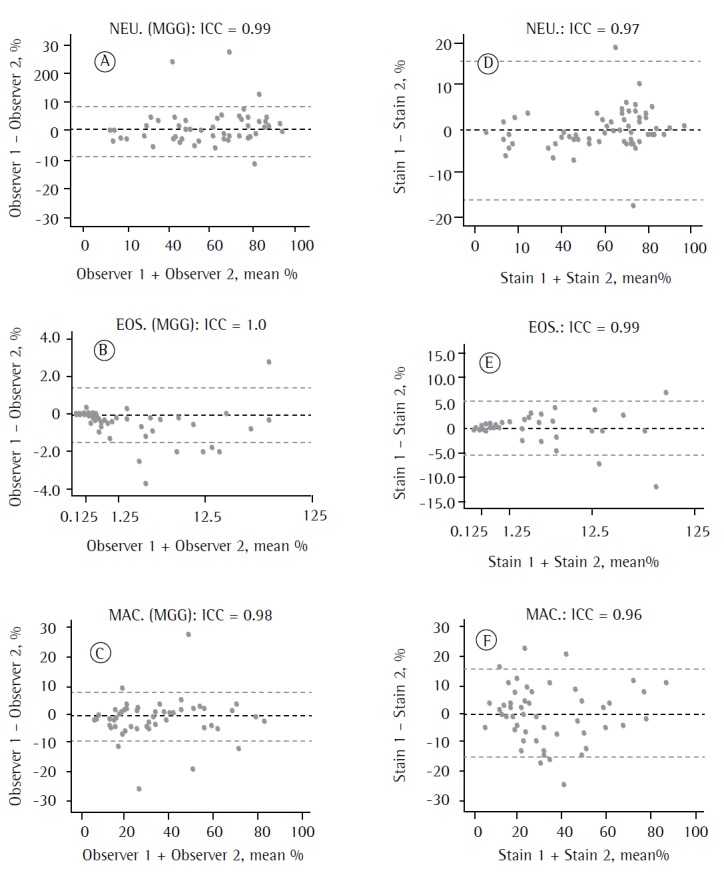
Bland & Altman plots. Interobserver reproducibility for the proportion
of neutrophils (in A), eosinophils (in B), and macrophages (in C) on the
cytospin slides prepared from induced sputum samples and stained with
May-Grünwald-Giemsa (MGG). Intraobserver reproducibility for the proportion of
neutrophils (in D), eosinophils (in E), and macrophages (in F) on the cytospin
slides prepared from induced sputum samples and stained by either of the two
staining techniques. The plots refer to the differences between the readings by
observers 1 and 2 (y axis) in relation to the mean readings by observers 1 and
2 (x axis). The central broken line indicates absence of differences, and the
peripheral broken lines indicate two standard deviations of the mean of the
differences. ICC: intraclass correlation coefficient; NEU.: neutrophils; EOS.:
eosinophils; and MAC.: macrophages.